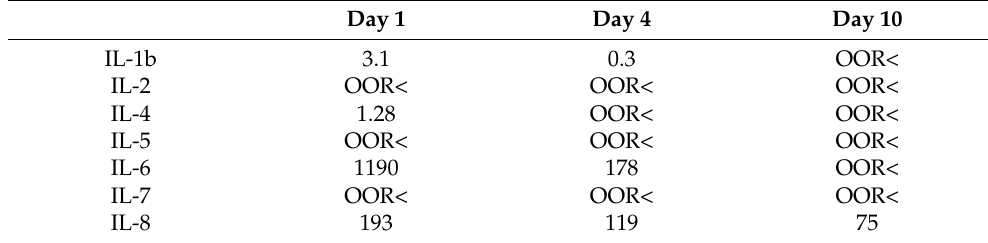
Figure 4. Phylogenetic analysis of the VP1 and P2 regions of the CV-A6 strains. ( Left ) Neighbor- joining tree based on the VP1 sequences (positions 2441 to 3355 correspond to the Gdula genome). ( Right ) Neighbor-joining tree based on the P2 sequences (positions 3356 to 5089 correspond to the Gdula genome). Both phylogenetic trees were tested using the bootstrap method for 1000 replicates, and values of >70 are shown at the nodes. • , CV-A6 Hyogo strains of this case. The serum cytokine profiles on day 1 were consistent with those of a viral infection (increased interleukin-6 (IL-6), interleukin-8 (IL-8), granulocyte-colony stimulating factor (G-CSF), interferon- γ (IFN- γ ), and tumor necrosis factor- α (TNF- α ) levels; Table 4). Table 4. Results of the serum cytokine